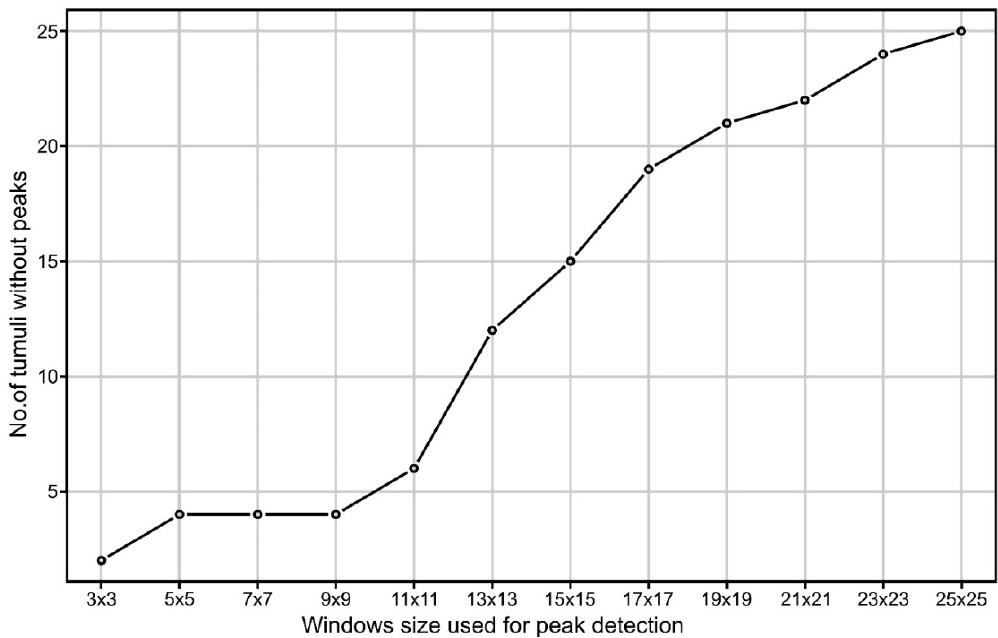
Figure 8. The variation of the number of delineated burial mounds without an identified peak as a function of the size of the window (in pixels) used for peak identification. (a high-resolution version can be found at